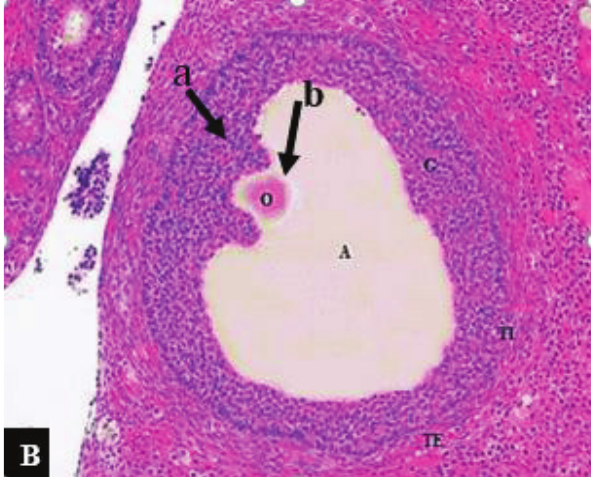
Fig-4B: Showing small sized Graafian follicle of group B with pyknosis (a) torn zona pellucida (b).(H&E,20x)